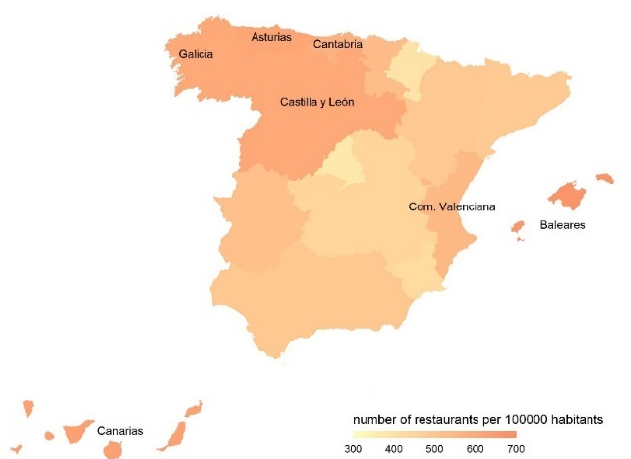
Figure 2. Number of restaurants in Spain per 100,000 habitants. Compiled by the authors using data from INE [39]. The regions with the highest ratio are Illes Balears (668.09), Islas Canarias (627.96), Asturias (613.49), Galicia (604.59), Castilla y León (603.99), Cantabria (568.87) and Comunitat Valenciana (545.42).